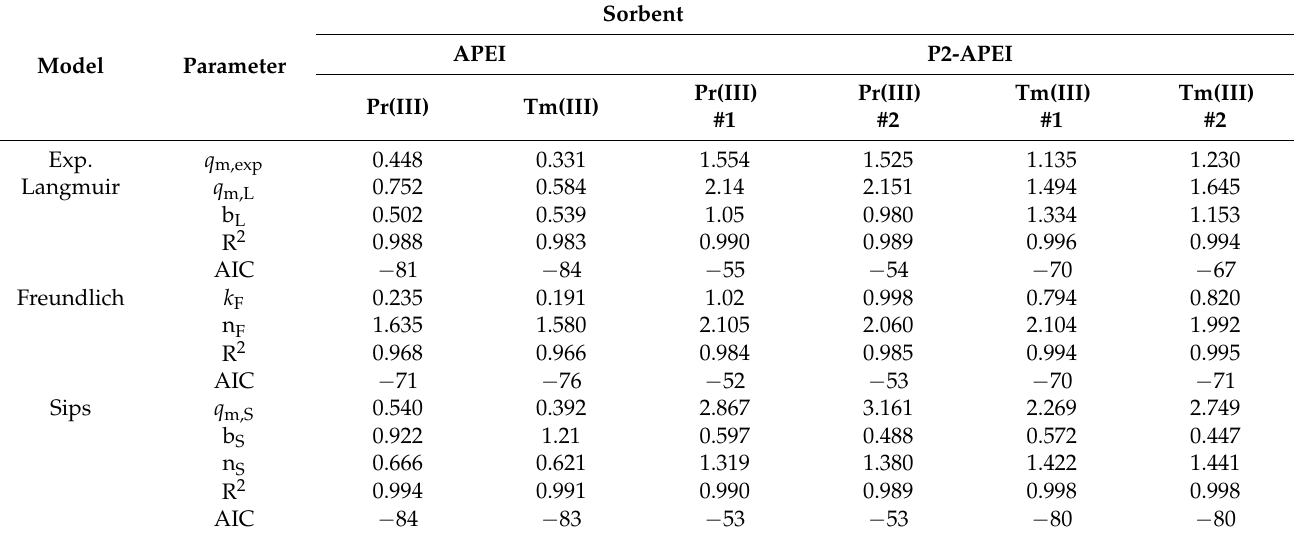
Table 4. Pr(III) and Tm(III) sorption isotherms using APEI and P2-APEI sorbents—fitting parameters for the Langmuir, Freundlich, and Sips